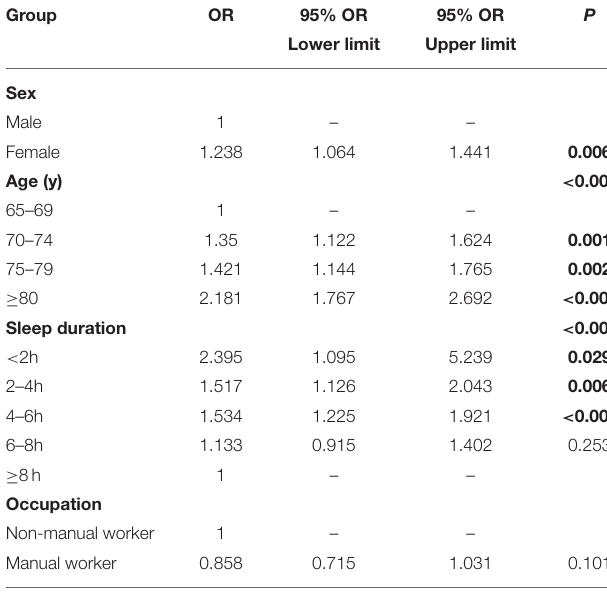
TABLE 3 | Logistic regression analysis of risk factors for constipation. Group